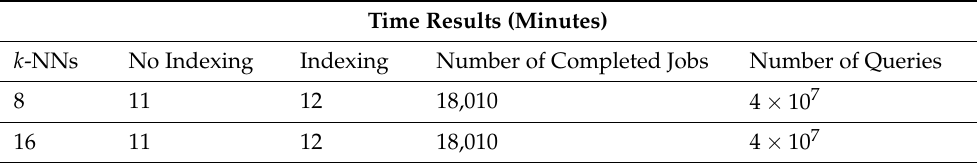
Table 9. Time for 2000 Mobile Objects without Indexing and with R -Tree